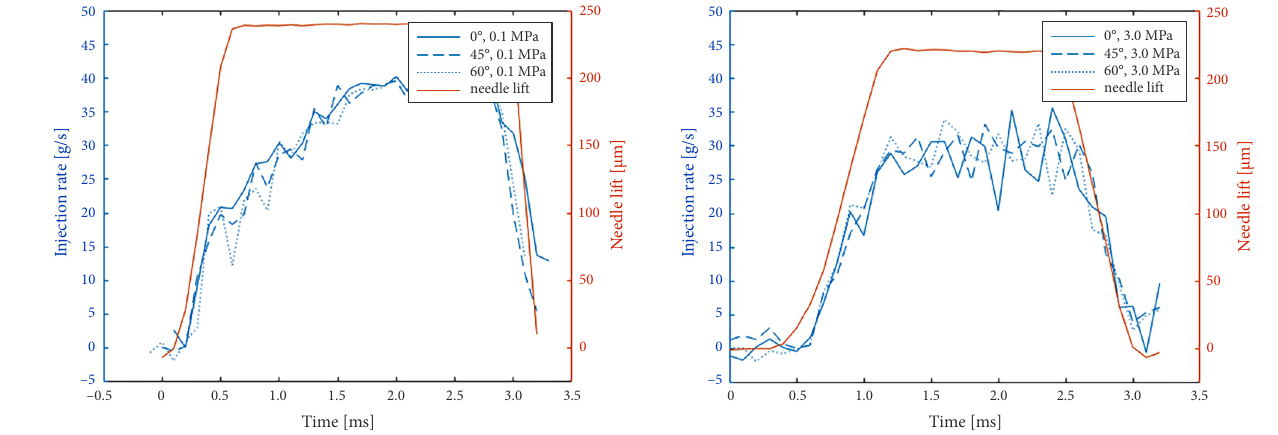
Figure 8. Measured injection rates and needle lift for 1400 min –1 , 400 N ⋅ m, 0.1 MPa backpressure value, with different plug valve positions